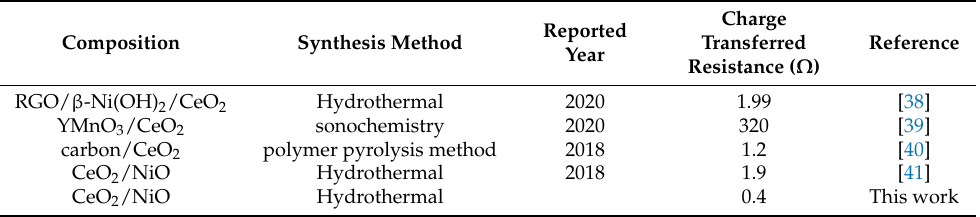
Table 3. Comparison of the present study with the literature.